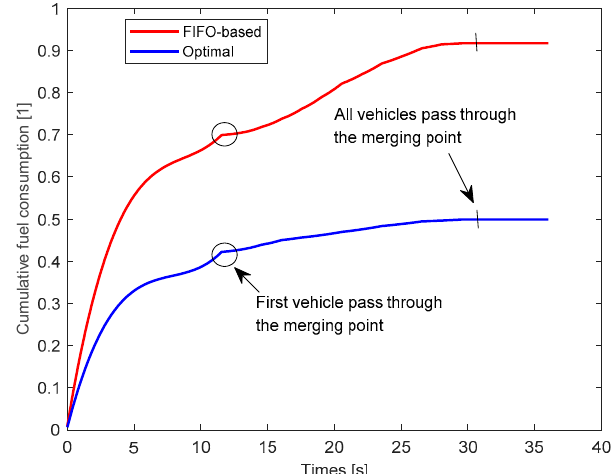
Figure 7. Cumulative fuel consumption of vehicles for case study 1.